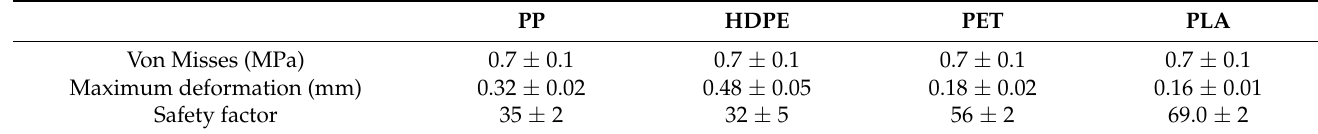
Table 7. Simulation results for the nanocomposites.